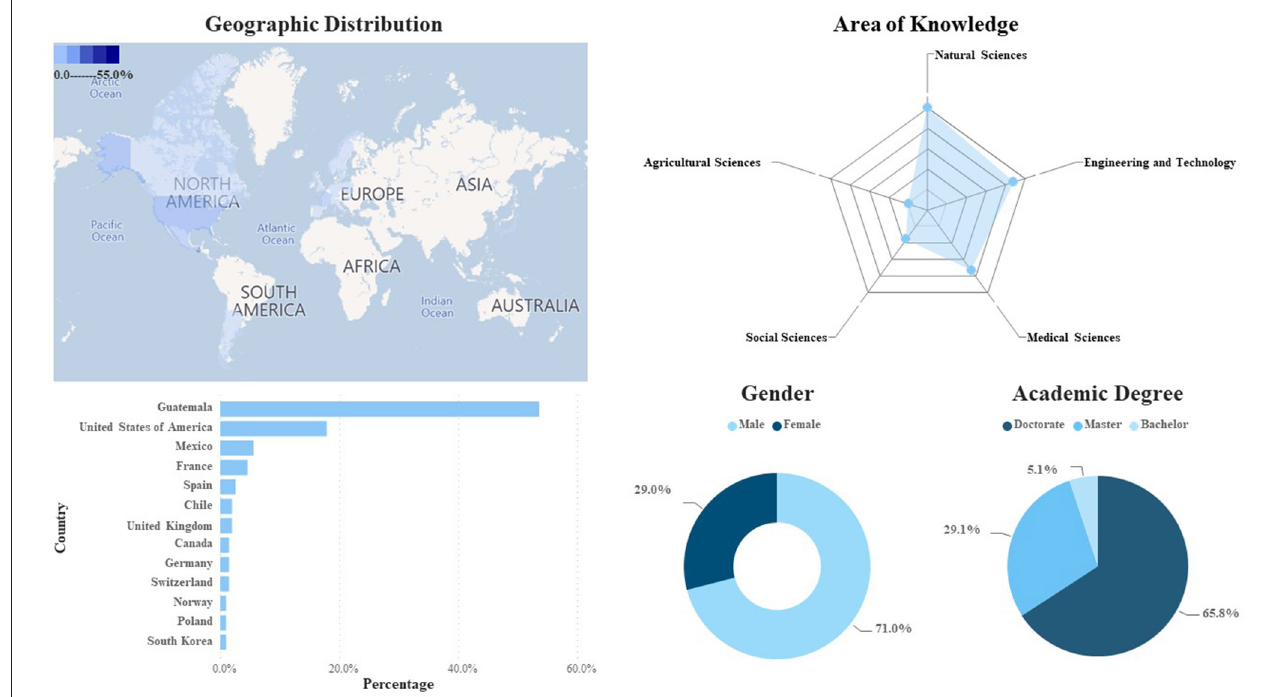
FIGURE 1 | Mapping of the GSD—based in two networks RedCTI/OWSD